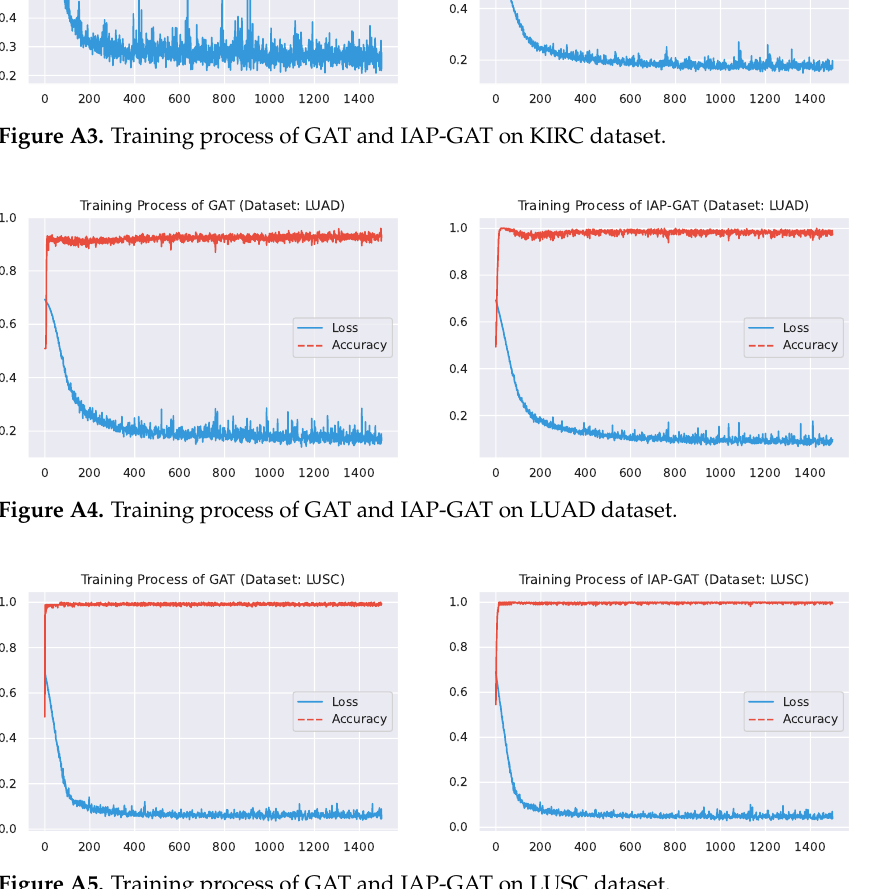
Figure A5. Training process of GAT and IAP-GAT on LUSC dataset.